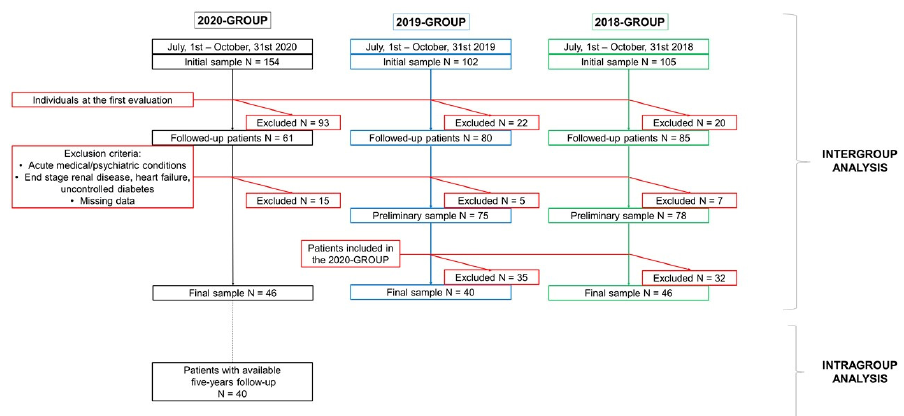
Figure 1. Sample selection flow chart for individuals with cognitive impairment evaluated at the Centre for Dementia and Cognitive Disorders in Vercelli, over the period July–October 2020, 2019, and 2018. In the 2020-GROUP, to perform a further intergroup analysis, data collection was extended to charts of individuals with annual follow-up in the period 2016–2020 to evaluate the five-year trajectory of cognitive decline.